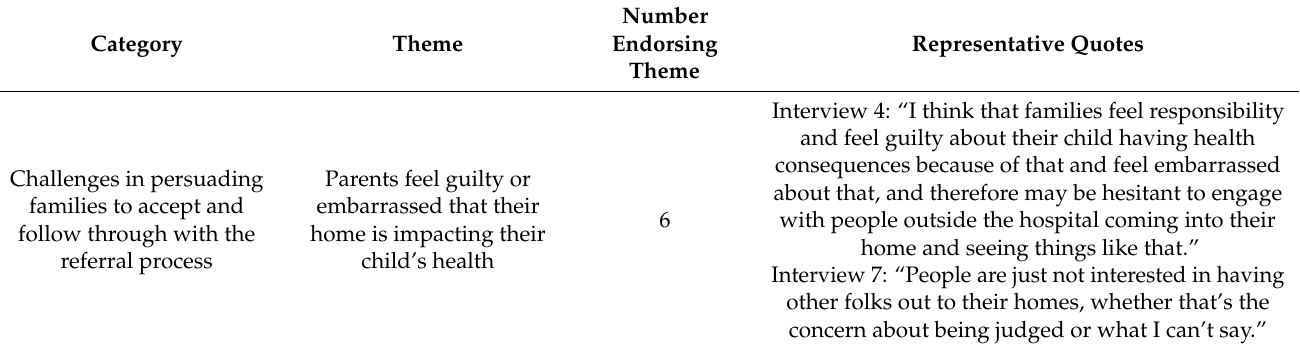
Table 3. Health professionals’ views of challenges in persuading families to accept and follow through with the referral process of the